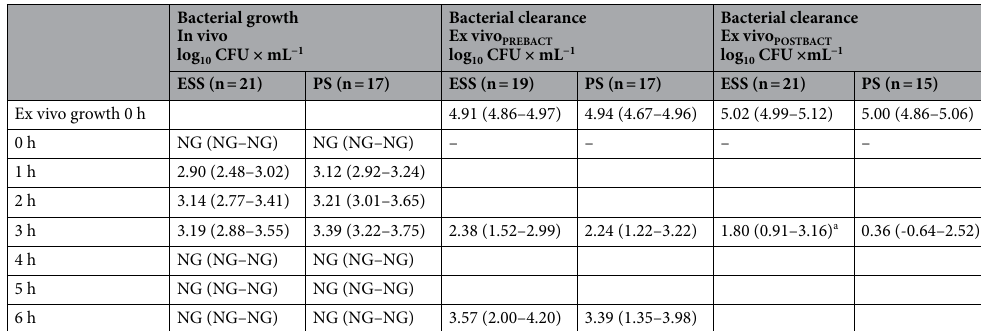
Table 2. Bacterial growth in blood cultures obtained in vivo and blood intrinsic bactericidal capacity expressed as bacterial clearance ex vivo in blood obtained before the bacterial challenge at 0 h (Ex vivo Prebact ) and 15 min after termination of the 3-h bacterial infusion (Ex vivo Postbact ) in animals with early secondary sepsis (ESS) and primary sepsis (PS). Bacterial clearance is calculated as the difference between growth at 0 h and the different time points. Due to a lack of time, ex vivo PREBACT analyses were not achieved in two ESS animals and in two PS animals in the ex vivo POSTBACT analyses. Values are median (interquartile range) log 10 CFU × mL −1 . NG = No growth, detection limit 5 CFU × mL −1 . The Mann–Whitney U test was conducted to determine differences between the ESS and PS groups at each time point. a p < 0.05 ESS versus PS.